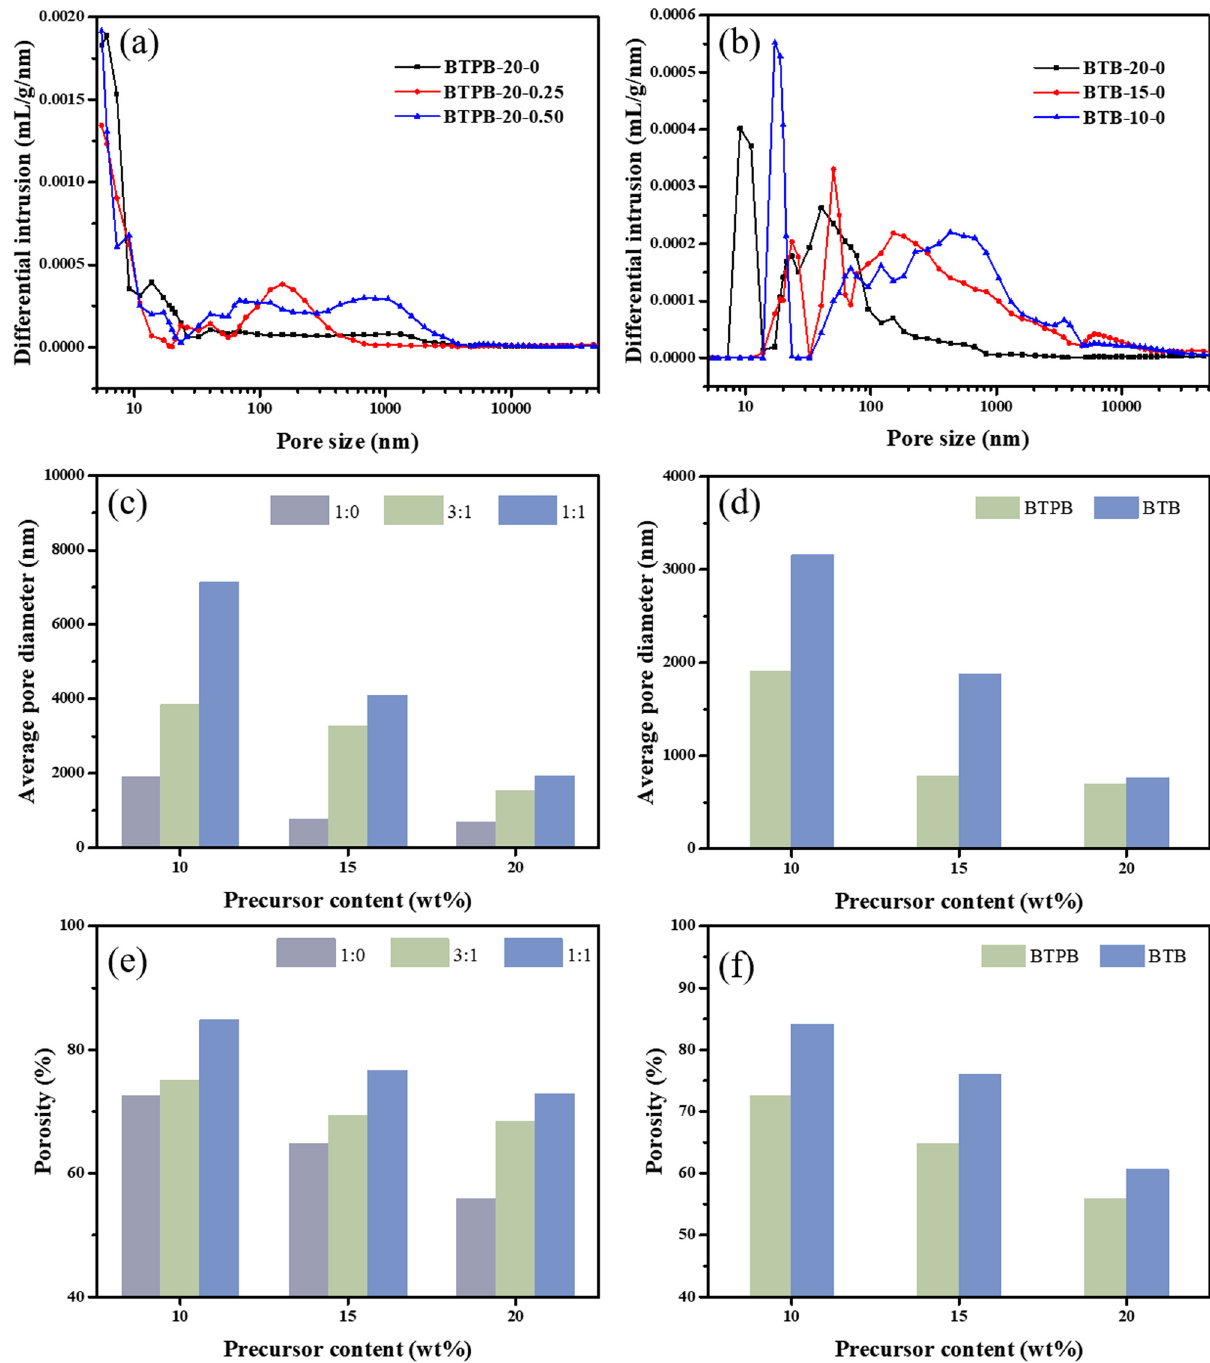
Figure 5: Pore diameter distributions of selected BPSQ aerogels: ( a ) BTPB ( /TMOS ) aerogels and ( b ) BTB aerogels. Average pore diameter of ( c ) BTPB ( /TMOS ) aerogels and ( d ) BTPB and BTB aerogels. Porosity of ( e ) BTPB ( /TMOS ) aerogels and ( f ) BTPB and BTB